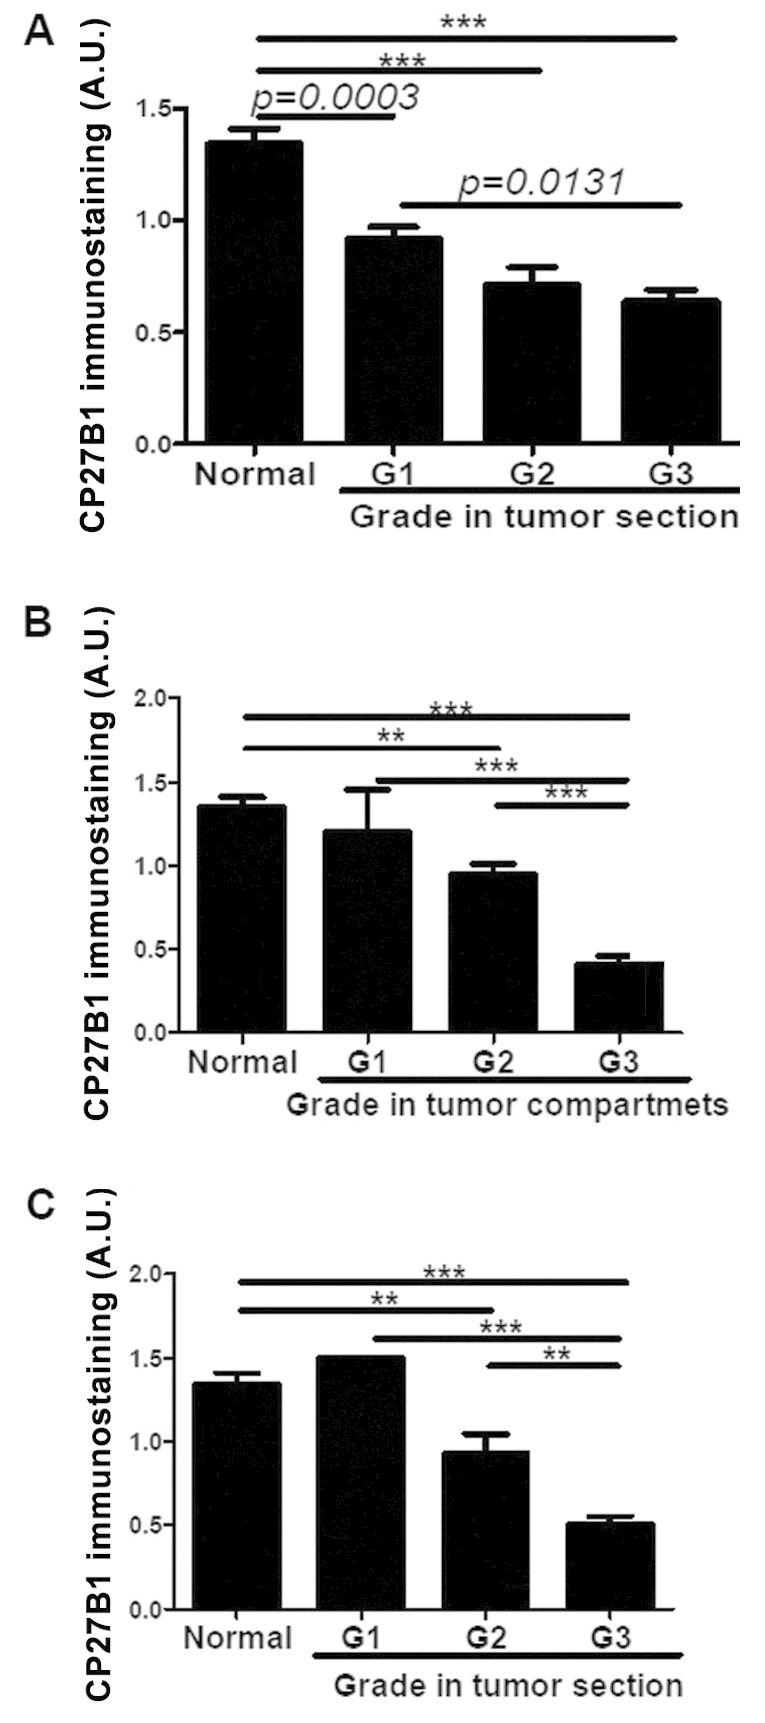
CYP27B1 immunostaining is inversely associated with tumor grade in primary cancers stratified according to tumor grade in whole section (A), tumor grade in separate compartment of the tumor (B) and in metastases (C). Statistically significant differences are denoted with p-values as determined by Student’s t-test and with asterisks by ANOVA **p<0.01 and ***p<0.001. A.U., arbitrary units.